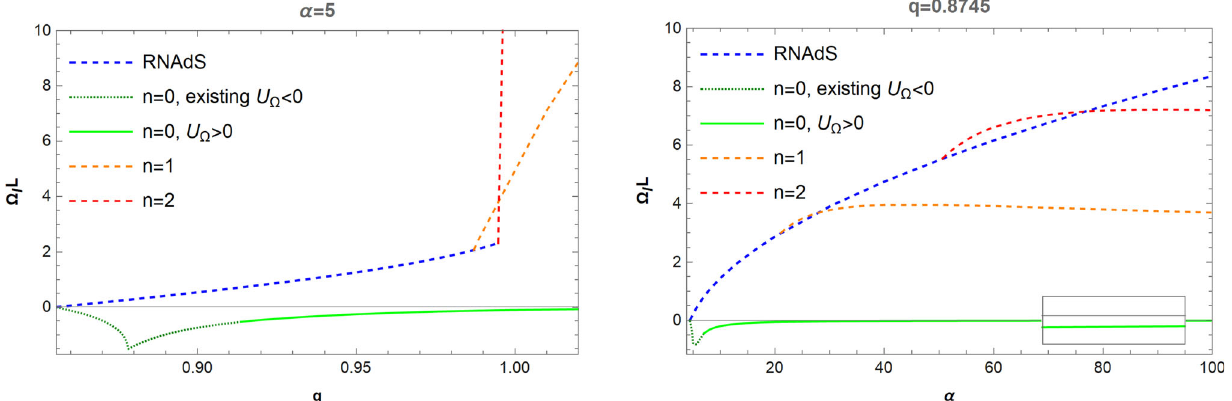
Fig. 2 Imaginary parts of the lowest-lying quasinormal modes of fun- damental scalarized black holes (green) and unstable modes of RNAdS blackholes(blue),andthefirst(orange)andsecond(red)excitedscalar- ized black holes as functions of reduced charge q for α = 5 (left) and functions of α for q = 0 . 8745 (right). Solid lines correspond to black holes with strictly positive potentials, dotted lines to black holes with- out unstable radial modes although the potential is not strictly positive,